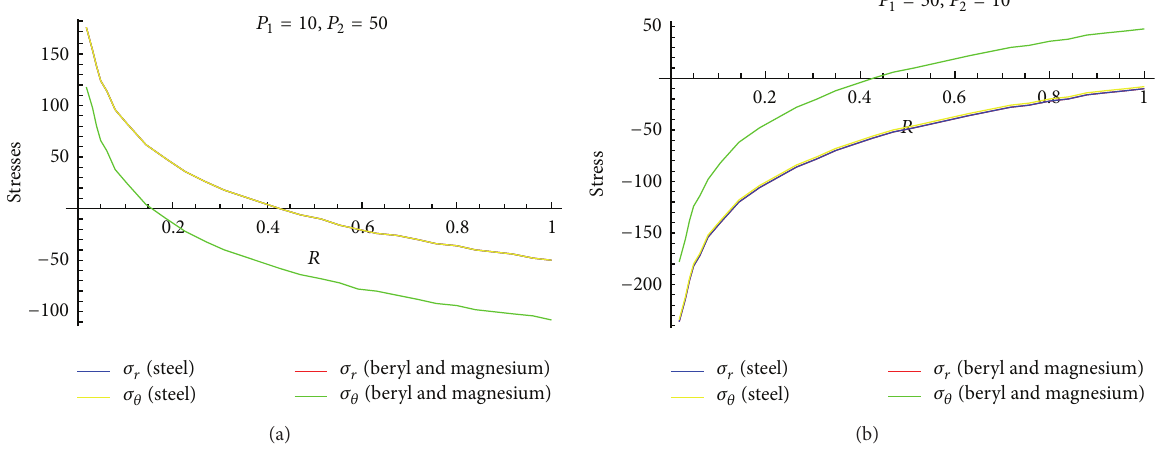
Figure 7: Fully plastic stresses when internal pressure = 10, external pressure = 50 and internal pressure = 50, external pressure = 10, respectively.